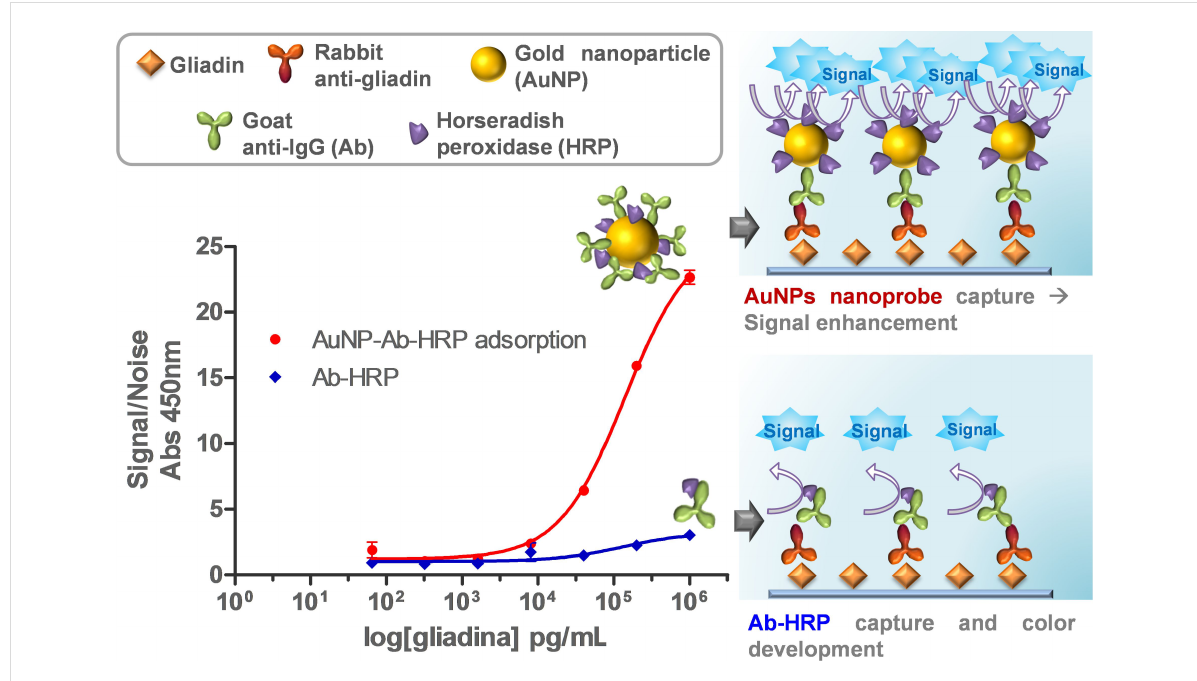
Figure 5: Schematic representation of gliadin detection by indirect ELISA and the basis of enhancement by means of AuNP probes. (Inset) Result of gliadin ELISA comparing AuNP probes prepared by adsorption (red curve) and Ab-HRP (blue). Results are represented as S/N ratio which repre- sents the absorbance at 450 nm of samples in the presence and absence of IgG respectively. Coefficient of determination R 2 = 0.9968 for AuNP probes and R 2 = 0.7971 for Ab-HRP. Note that assayed concentrations are around the theoretical LOD of